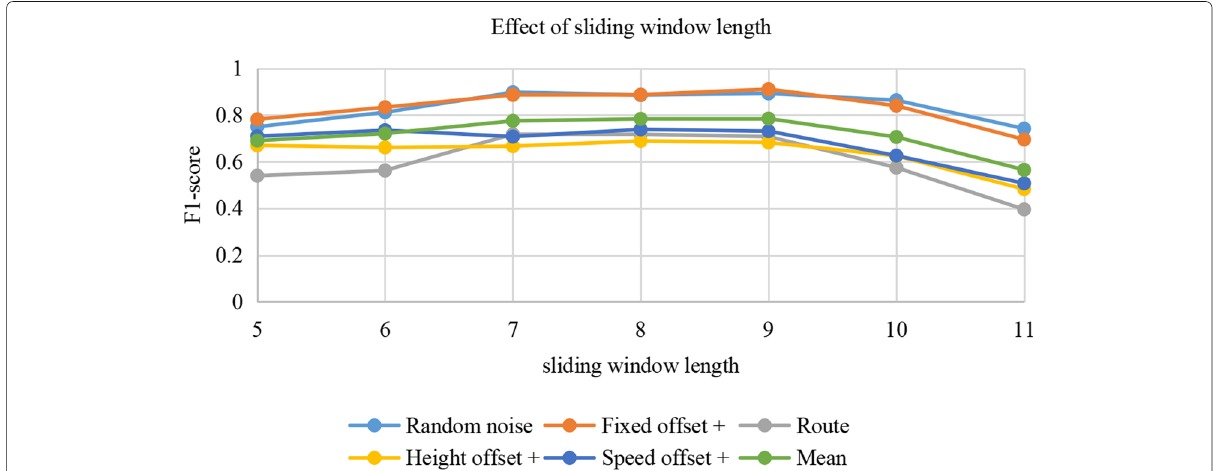
Fig. 8 Effect of sliding window length. Effect of sliding window length on the detection effect for five representative types of anomaly